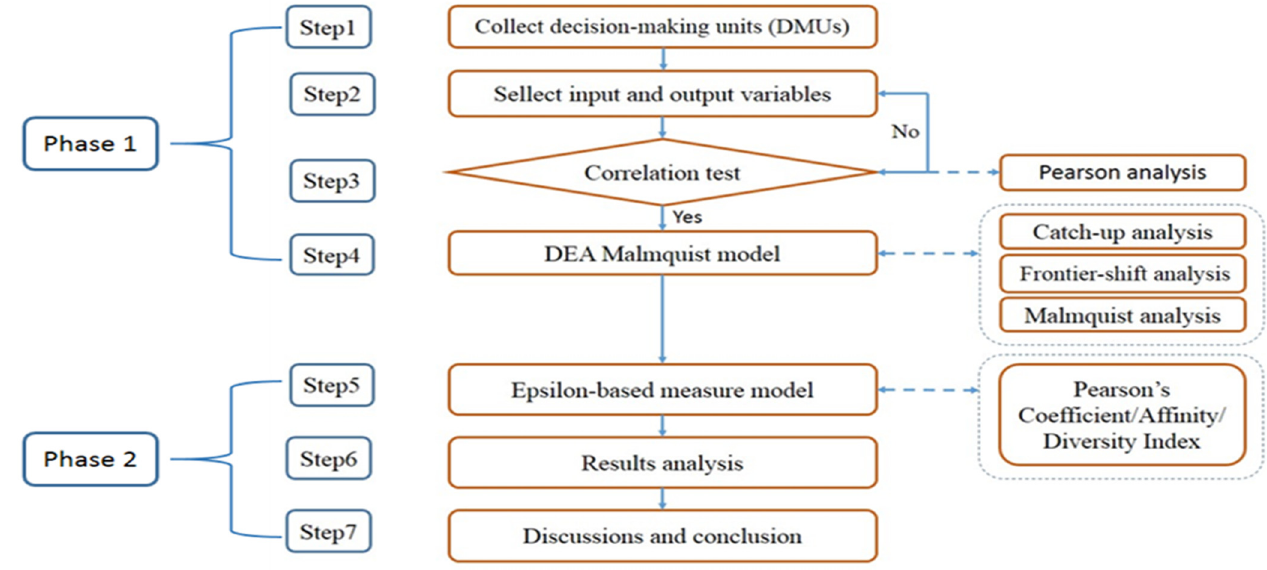
Figure 3. Research Figure 3. Research framework.